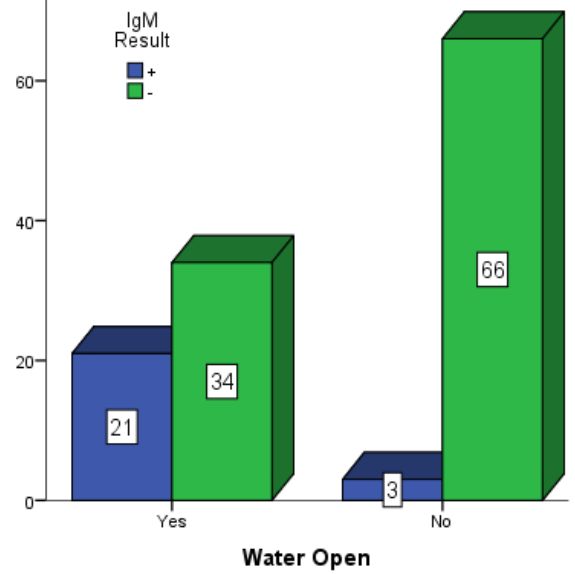
Figure 6. Participants with open water in their surroundings in Jimeta.